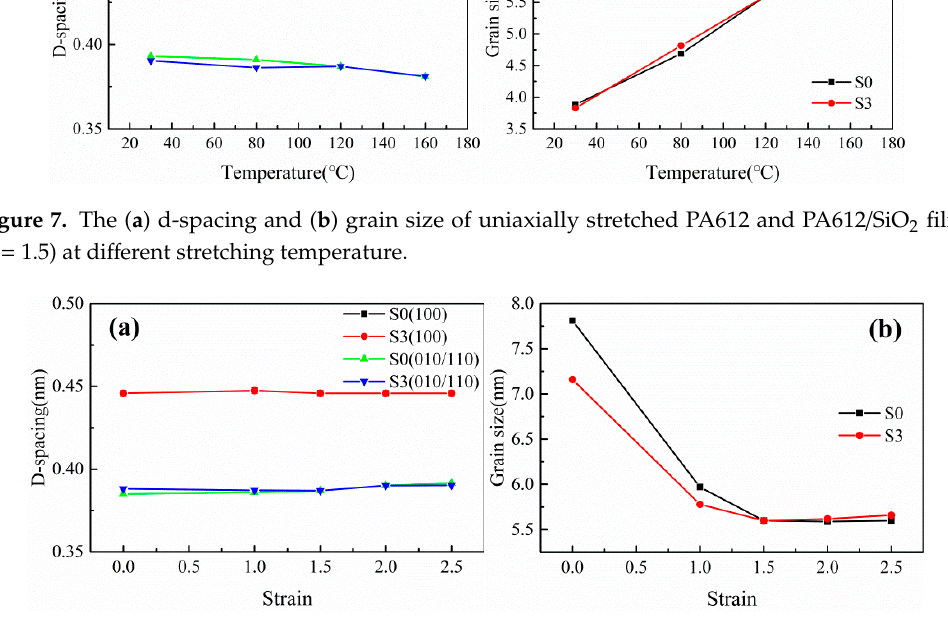
Figure 8. The ( a ) d-spacing and ( b ) grain size of uniaxially stretched PA612 and PA612/SiO 2 films at different strain.